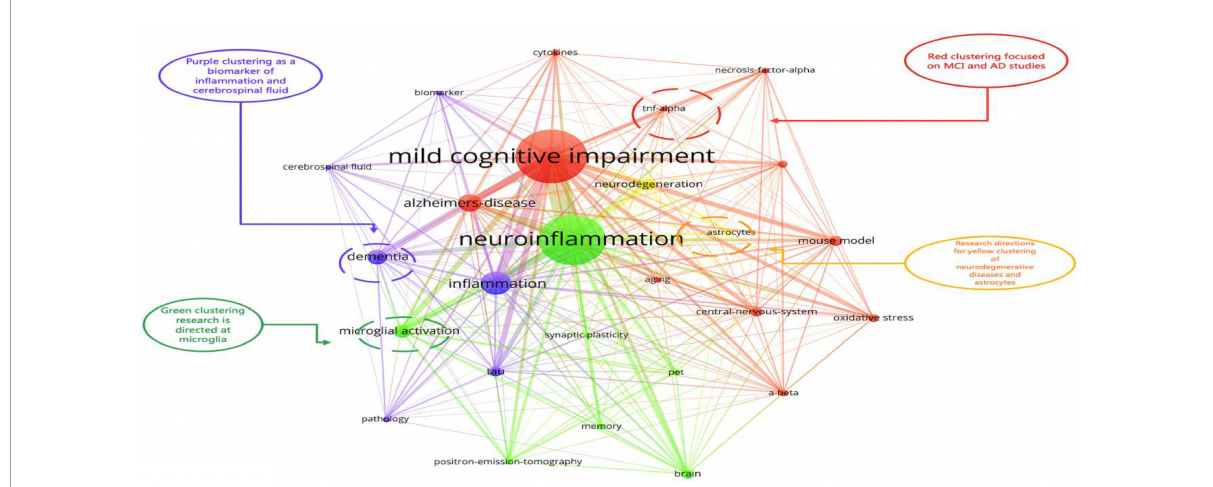
FIGURE9 The co-citation timeline zone of keywords created using CiteSpace. The size of the node reflects the co-occurrence frequencies, and the link indicates the co-occurrence relationship. Nodes and lines change over time from 2012 to